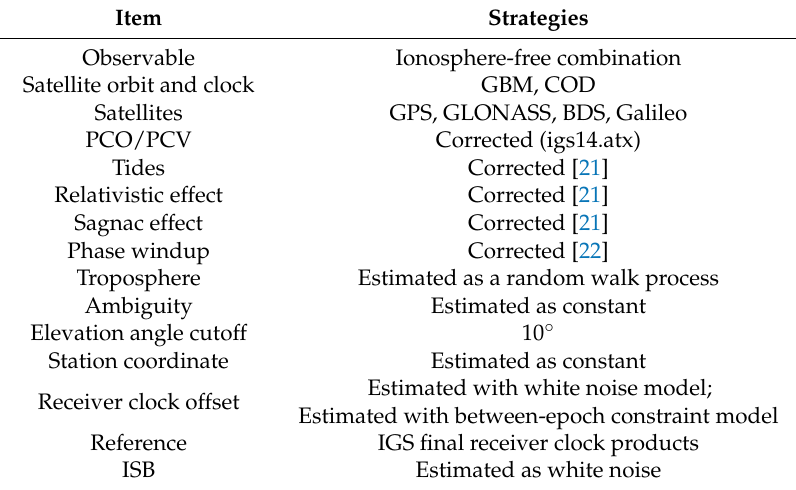
Table 2. Details of precise point positioning (PPP) processing